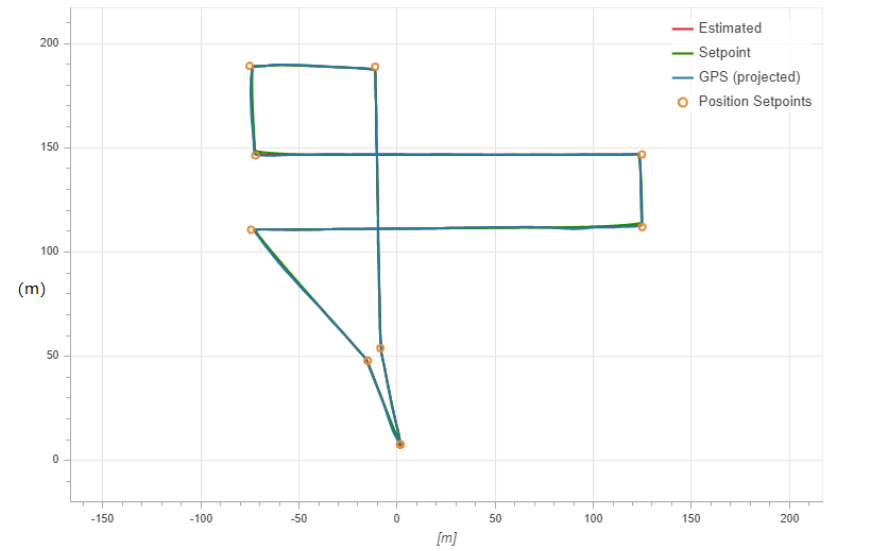
Figure 9. The pre-planned path for the transportation tests.